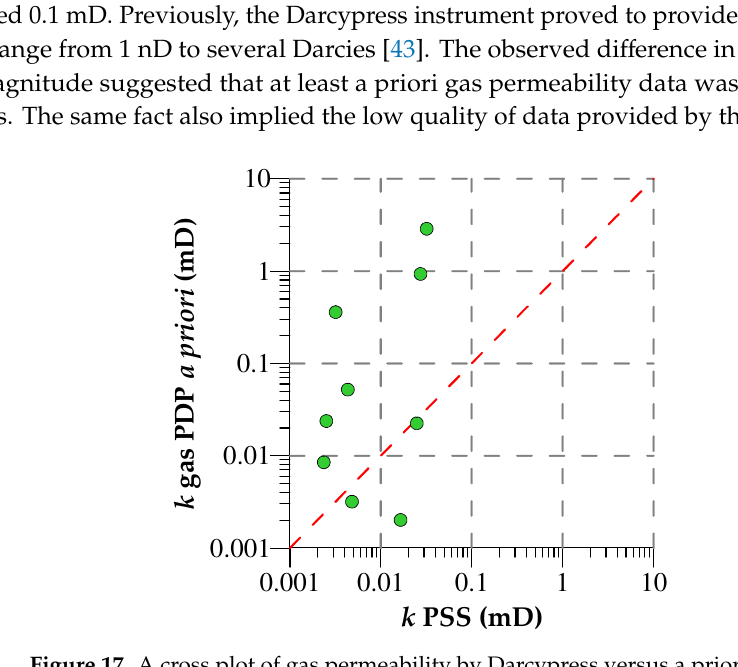
Figure 17. A cross plot of gas permeability by Darcypress versus a priori